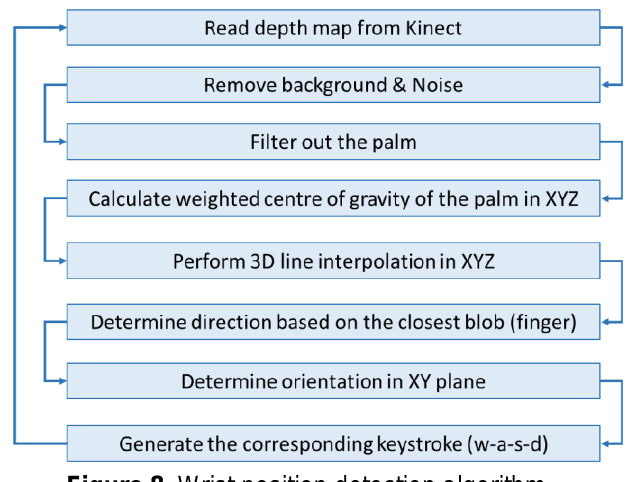
Figure 8. Wrist position detection